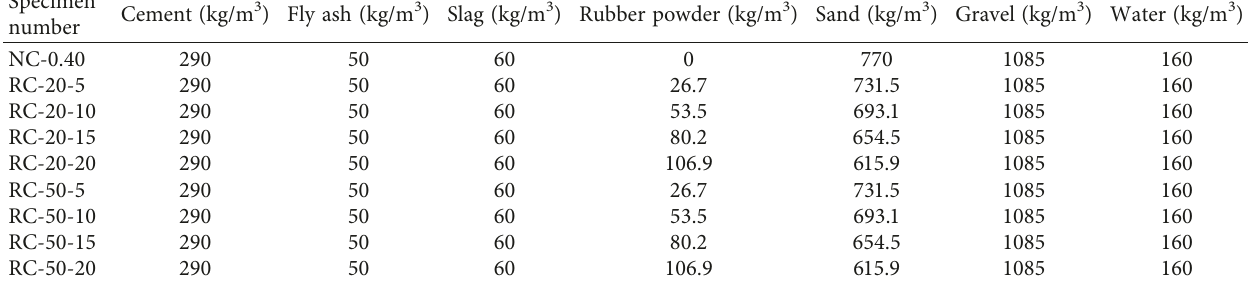
Table 6: Proportions of the rubber concrete mixes.